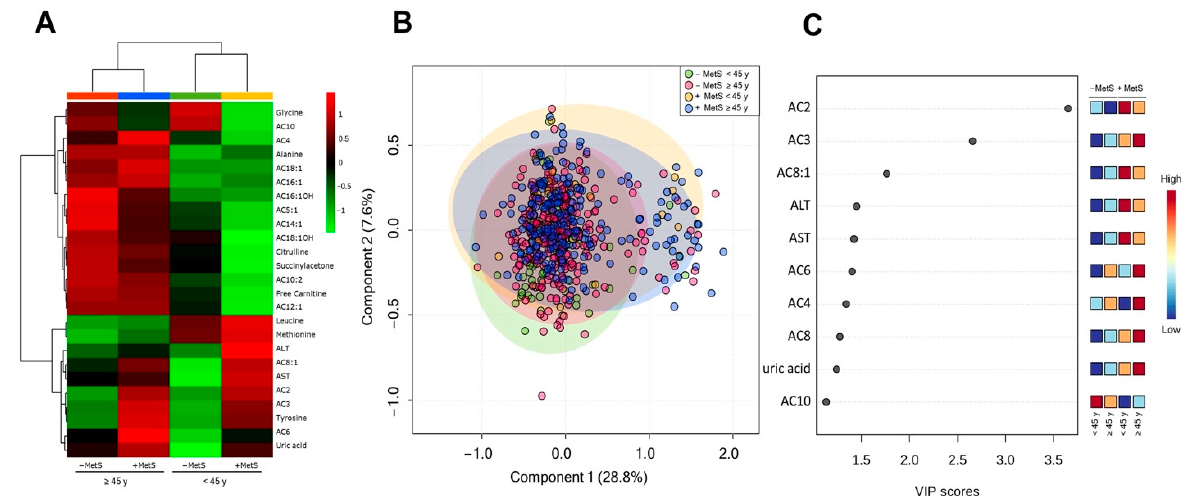
Figure 4. Serum metabolite profile according to MetS status and age. ( A ) Hierarchical heatmap for MetS diagnosis and age: − MetS < 45 years (green), − MetS ≥ 45 years (red), +MetS < 45 years (yellow), and +MetS ≥ 45 years (blue), red and green show an increase and decrease concentration, respectively. ( B ) PLS-DA plot shows separation between groups: − MetS: <45 years (green) and ≥ 45 years (red); +MetS: <45 years (yellow) and ≥ 45 years (blue). The explained variances are shown in brackets (accuracy 0.51; R2 0.086; Q2 0.040: permutation p value < 5.0). ( C ) VIP analysis represents the relative contribution of metabolites to the variance among groups. A high VIP score indicates a greater contribution of the metabolites to the group separation. Red and blue boxes on the right indicate whether metabolite concentration is increased (red) or decreased (blue). − Mets (without MetS), +MetS (with MetS).